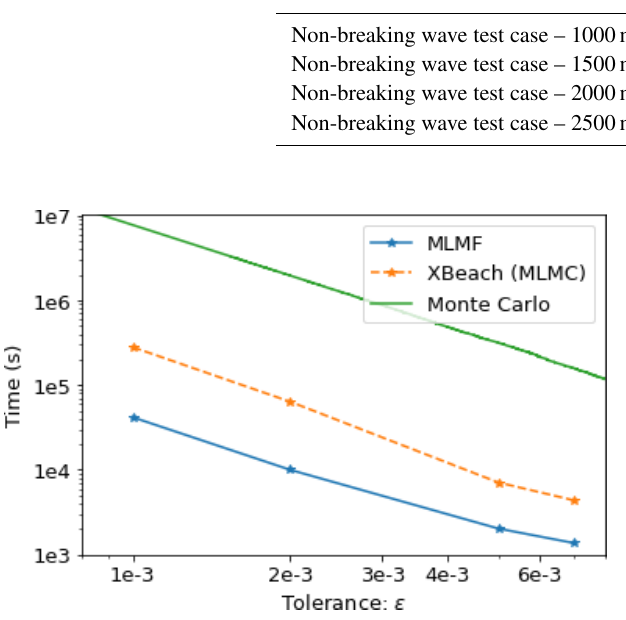
Figure 12. Comparing the computational cost required to achieve tolerance (cid:15) using MLMF, XBeach with MLMC and the Monte Carlo method for the non-breaking wave test case.